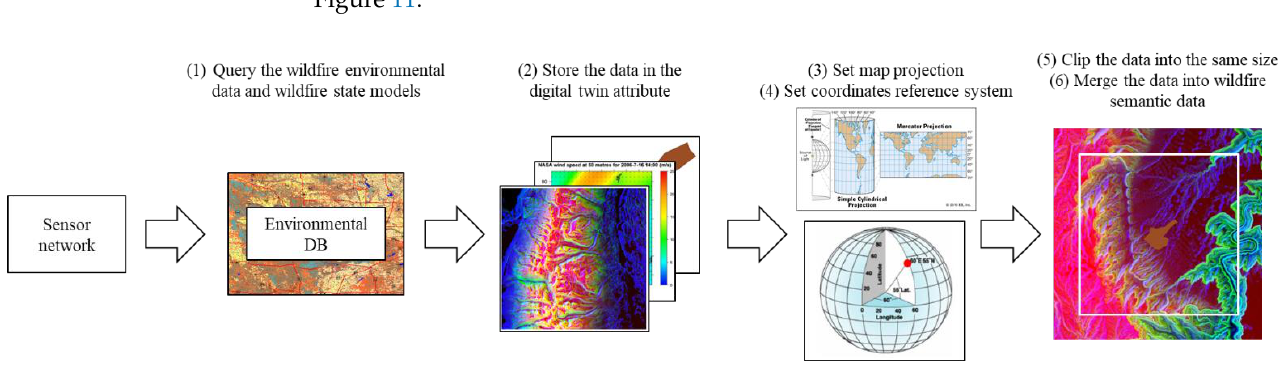
Figure 10. The architecture of the distributed computing scheme.